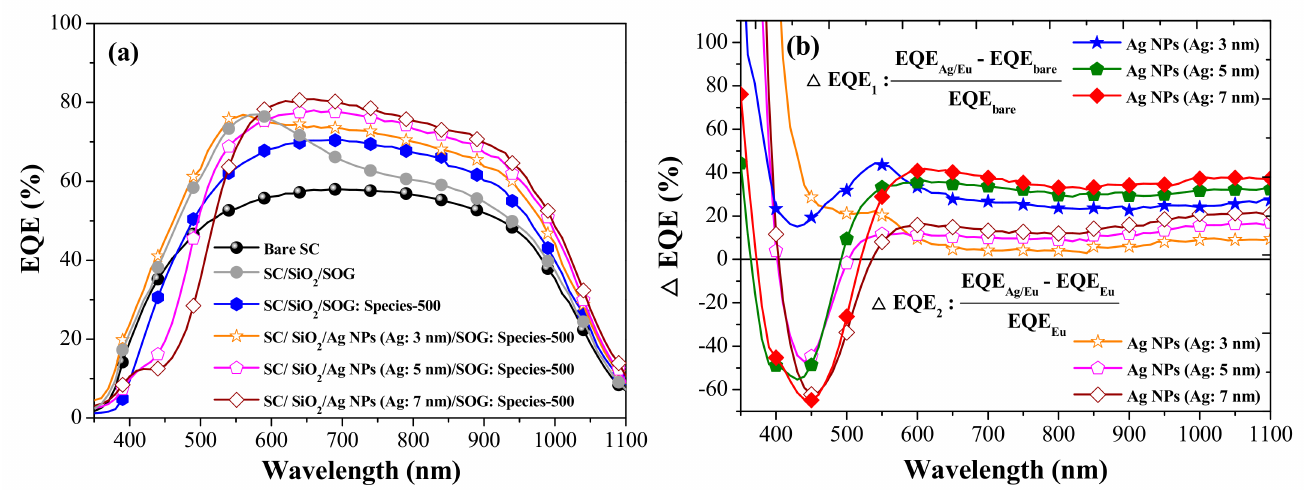
Figure 14. ( a ) EQE responses of bare silicon solar cell, cell with spacer/SOG, cell with spacer/SOG: phosphors (species-500), and cells with spacer/NPs/SOG: phosphors (NP: 3, 5, 7 nm); ( b ) EQE enhancement ( ∆ EQE )